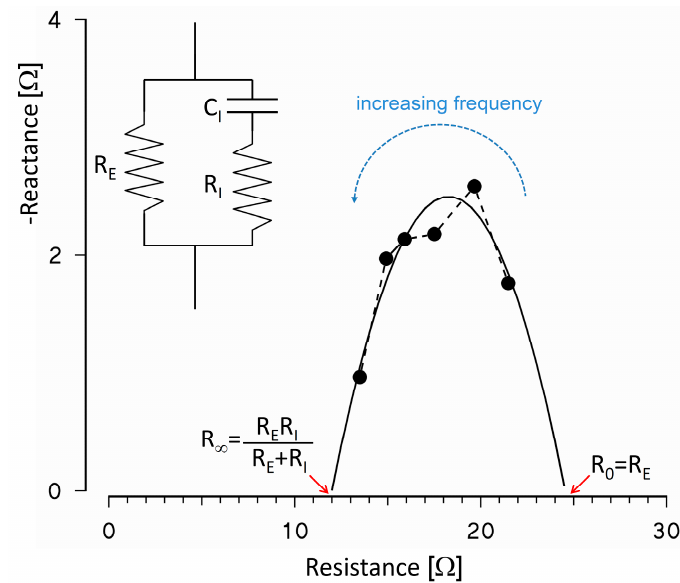
Figure A1. Resistance and reactance of Z(f) values in the β -dispersion range (solid circles) fitting the simplified equivalent electric circuit represented by the resistance R E of extra-cellular fluids in parallel with the membrane capacitance C I and the resistance R I of intra-cellular fluids (see inset); the mathematical curve that interpolates the measured values crosses the resistance axis at R 0 (corresponding to the model resistance when a DC current is injected) and at R ∞ (corresponding to the equivalent resistance of the model at infinite frequency). The example shows Z(f) data measured in the inactive thigh during recovery in sitting position.